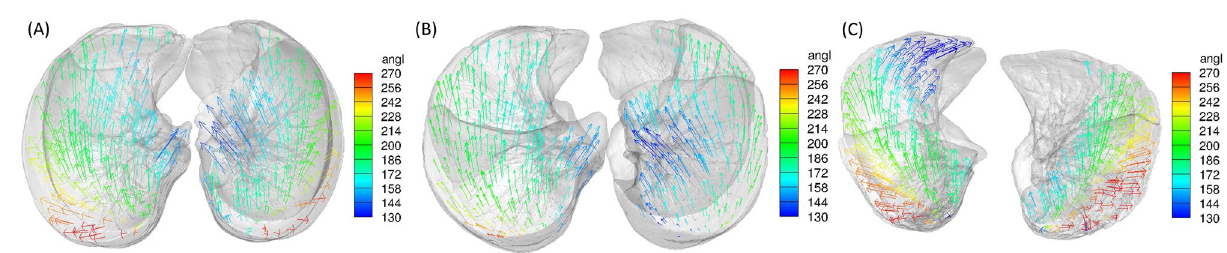
Figure 2. Demonstrative images of the three subject groups viewed from the below. Arrows are displacement vectors of the diaphragm which are color-coded by the displacement angle (‘angl’ written on the right represents the angle of dorsoventral-transverse displacement vector). ( A ) Normal. ( B ) Emphysema. The posteromedial portion of the diaphragm shows smaller displacement angle than normal controls. ( C ) IPF. The anteromedial portion of the diaphragm shows smaller displacement angle than normal controls. Note that heterogeneous displacement angles are demonstrated especially in the posterior portion of the left diaphragm in this For displacement angles of the whole diaphragm, there was no significant difference between both patient groups and normal controls (189.54 degrees in normal versus 186.72 degrees in emphysema [ P = 0.215], and 192.09 degrees in IPF [ P = 0.422]). However, the posteromedial quadrant in emphysema patients and the antero- medial quadrant in IPF subjects demonstrated significantly smaller displacement angle than normal controls (168.60 versus 177.24 degrees, P = 0.005; 156.85 versus 172.33 degrees, P = 0.011). The standard deviation (SD) of displacement angles in both emphysema and IPF groups was greater compared to normal subjects.